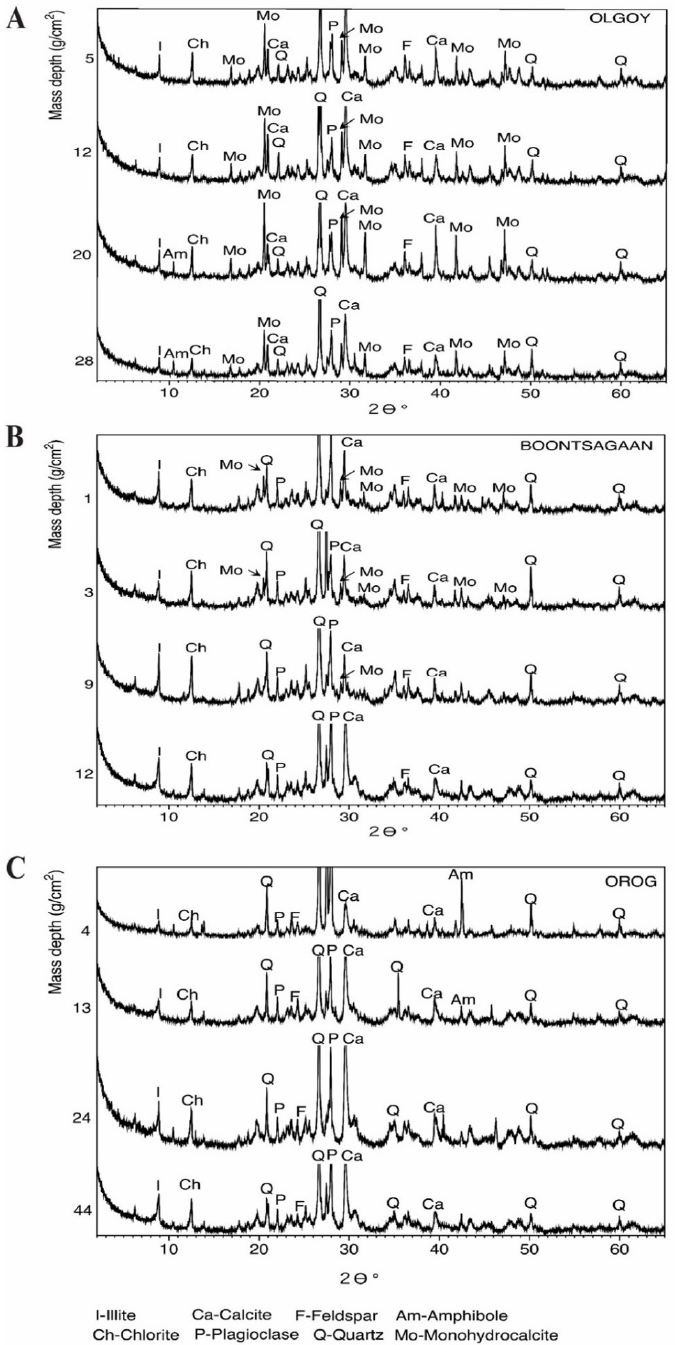
Figure 5. XRD results of the sediment from ( A ) Olgoy, ( B ) Boontsagaan, and ( C ) Orog lakes. Amphibole is found in Orog Lake (Figure 5C), but it is not evident in Olgoy nor Boontsagaan Lakes. Olgoy and Boontsagaan Lakes belong to the same catchment area, which is different from that of Orog Lake. The existence of amphibole may reflect